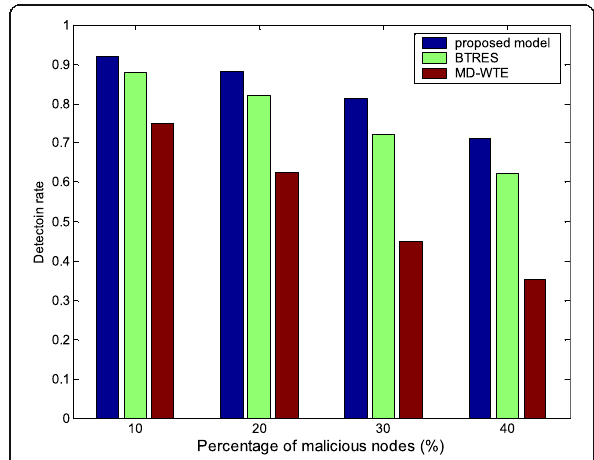
Fig. 5 The detection rate with different percentage of malicious nodes